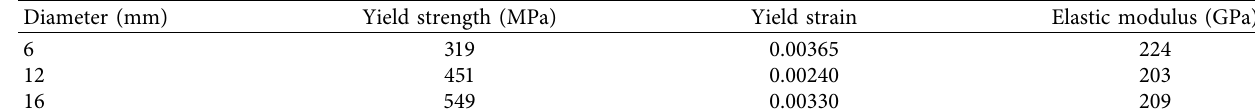
Table 1: Properties of reinforcement.